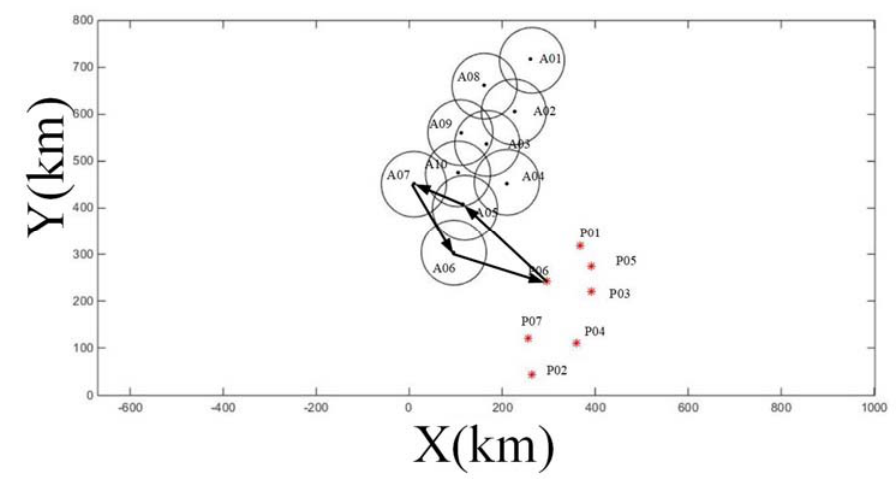
Figure 13. The flight path of the FY ‐ 2 No2 UAV.